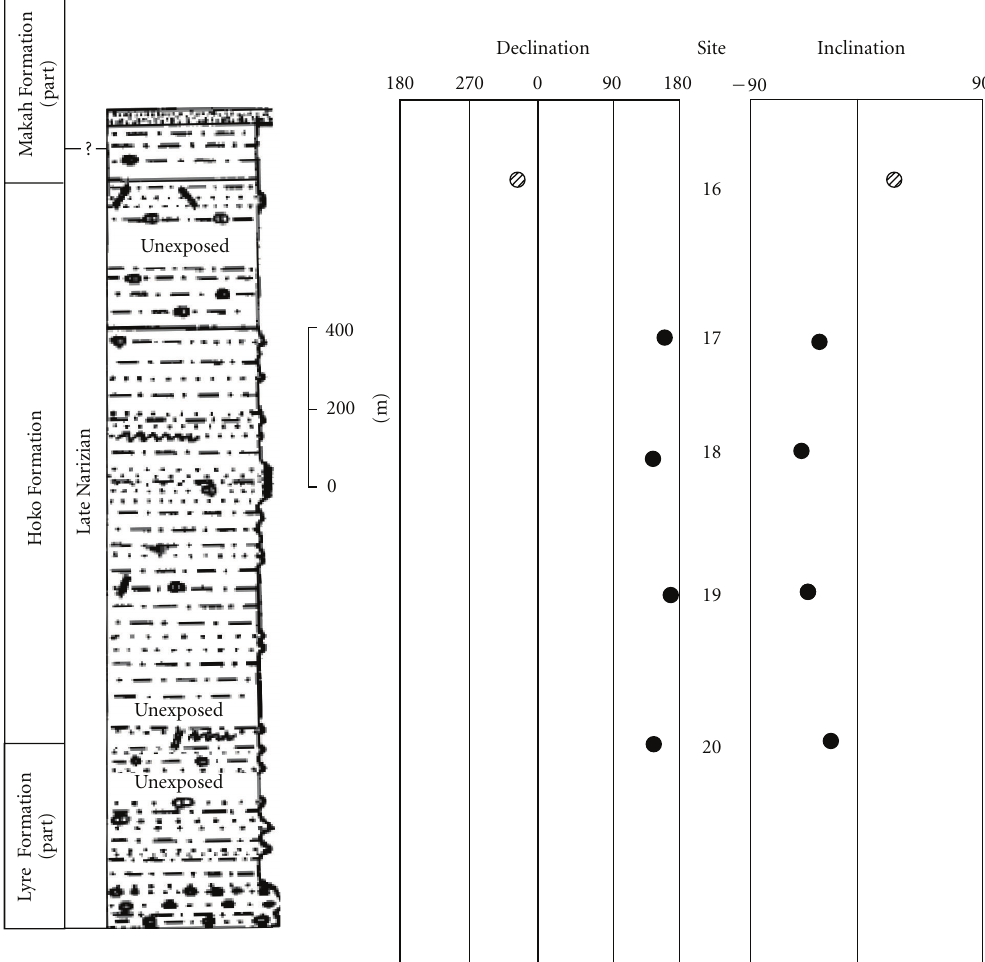
Figure 9: Magnetic stratigraphy of type section of the Hoko River Formation along Ozette Highway. Stratigraphy after Snavely et al. [24, Figure 10]. Conventions as in Figure